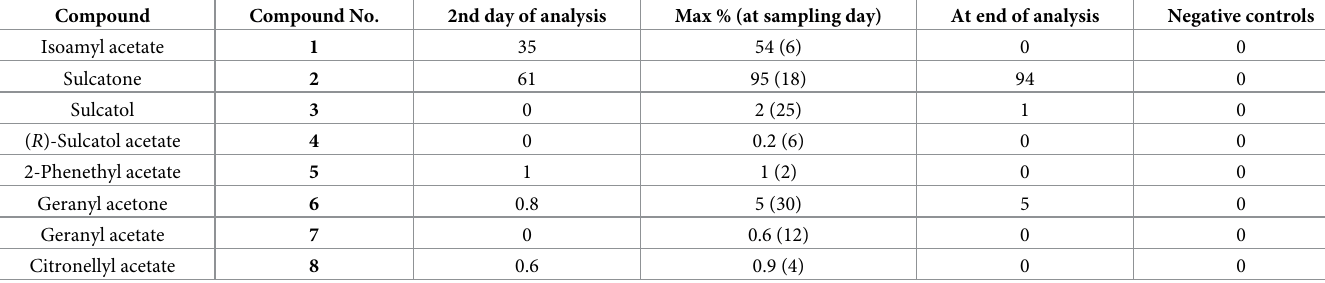
Table 1. Relative amounts (%) of total volatiles emitted by ER over time by SPME analysis. Compound Compound